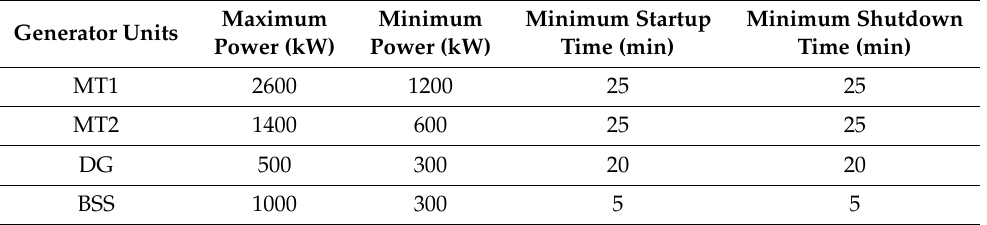
Table 2. Operational power limits of all generating units.